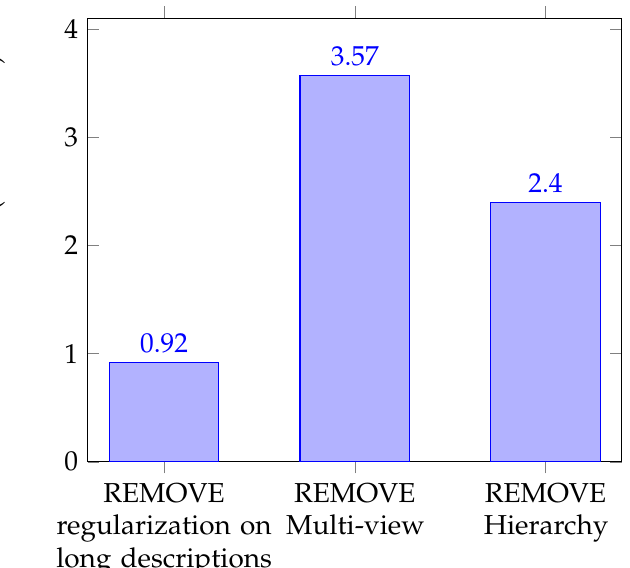
Figure 9. Ablation study on highest performing model (hierarchical MVC-RLDA) for CodiEsp dataset.